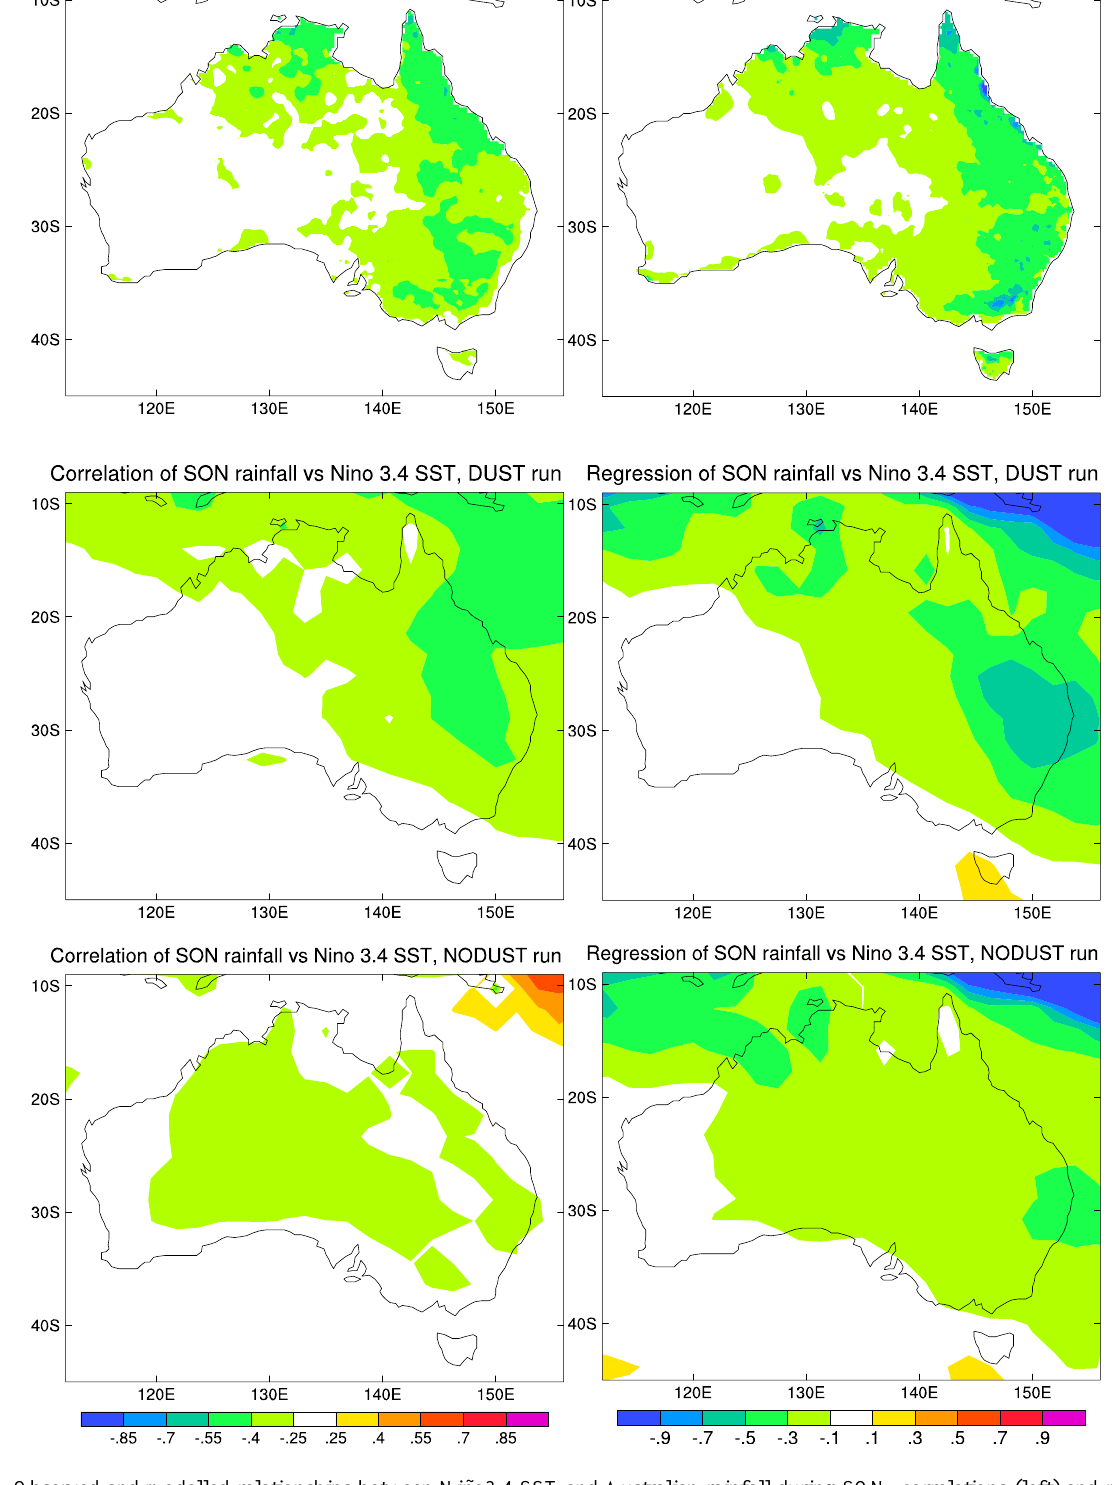
Fig. 5. Observed and modelled relationships between Ni˜no3.4 SST and Australian rainfall during SON: correlations (left) and regression slopes (right, in mm per day per Kelvin), from observations for 1901–2007 (top), the DUST run (middle) and the NODUST run